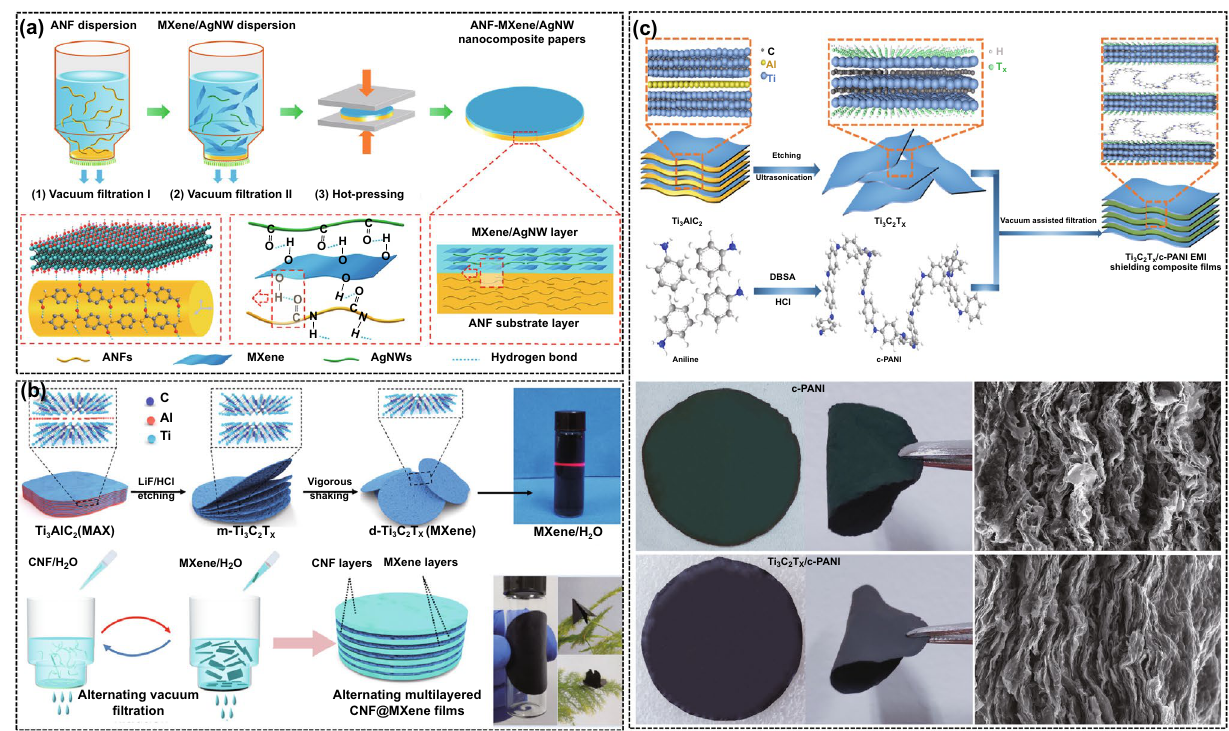
Fig. 11 Schematic illustrating the fabrication and SEM images of a ANF-MXene/AgNW, b CNF@MXene, and c MXene/c-PANI composite films [124–126]. Copyright © 2020 American Chemical Society. Copyright © 2019